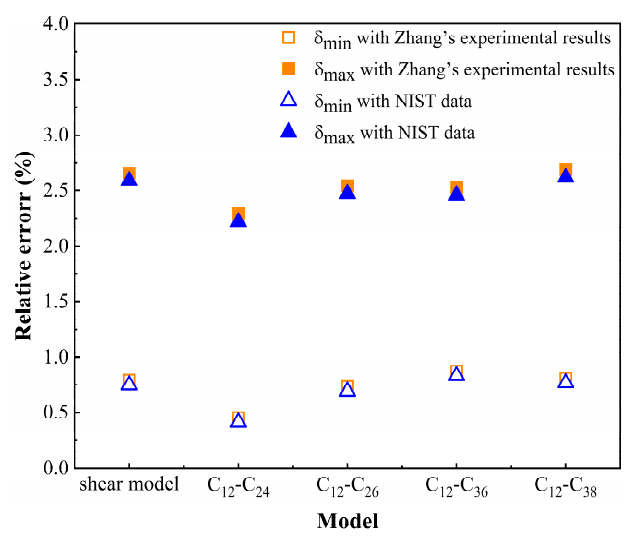
Figure 4. The comparison of density of C 12.